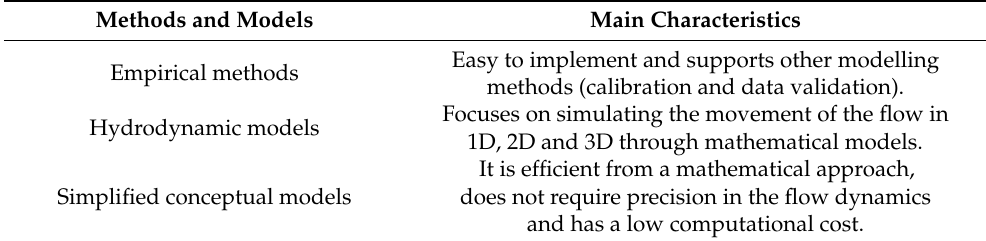
Table 1. Classification of methods and models by their main characteristics